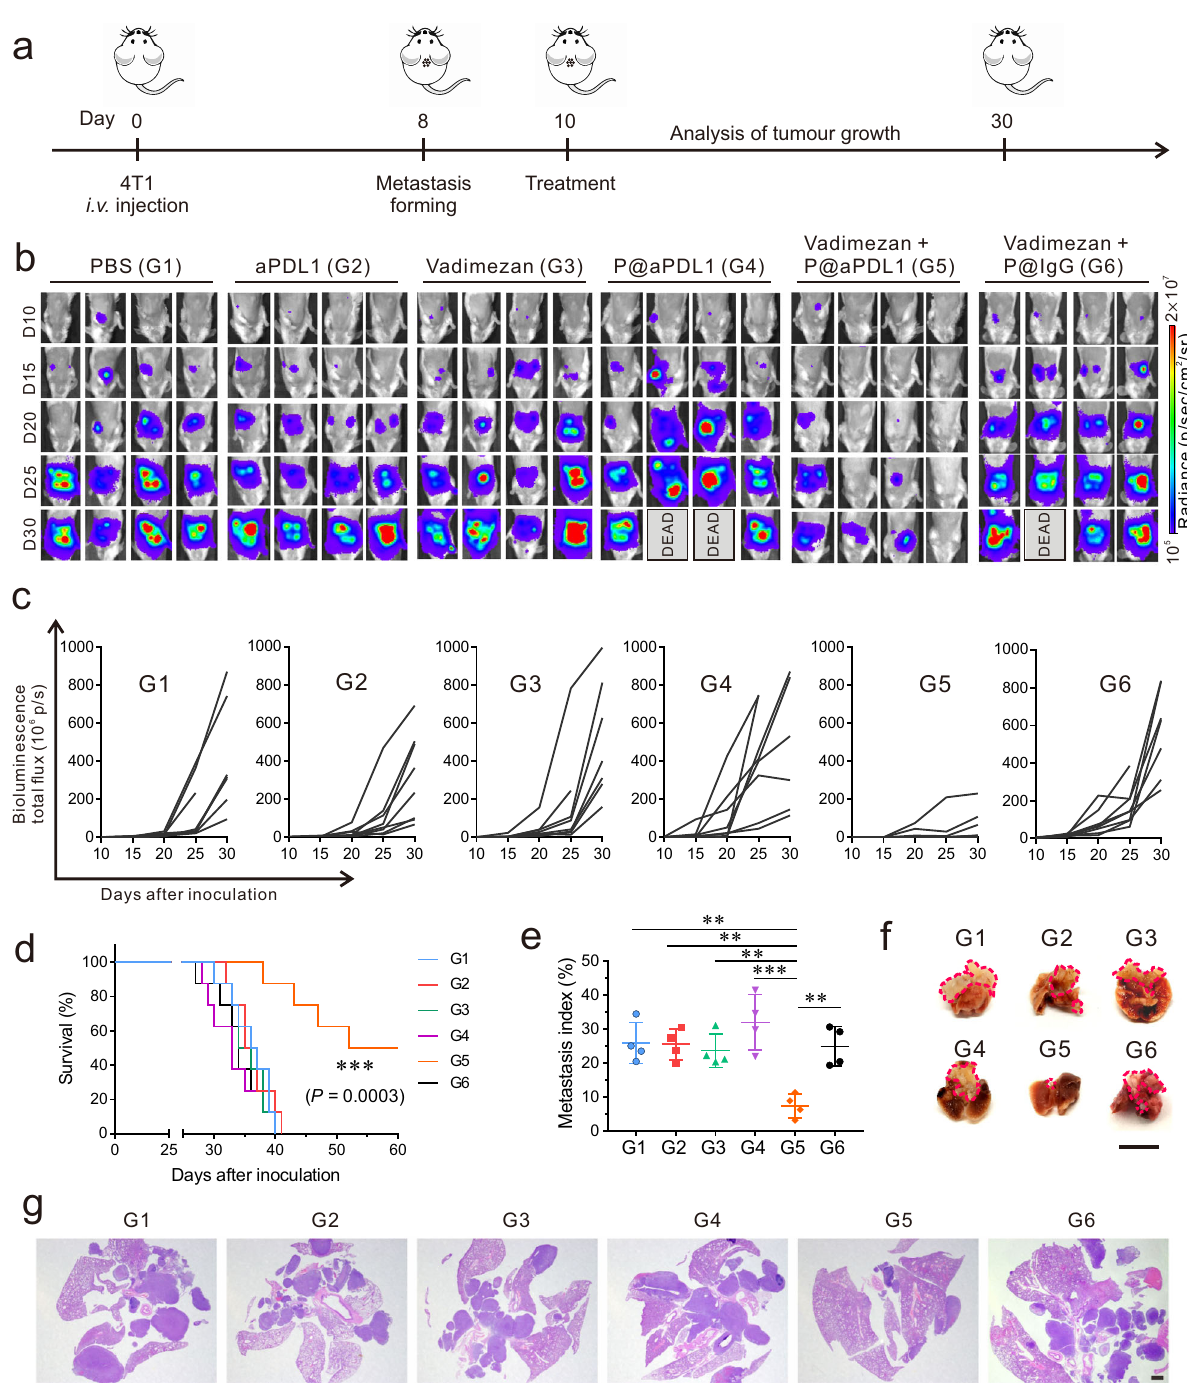
Fig. 3 P@aPDL1 combined with Vadimezan promotes anti-tumour effects in the 4T1 tumour model. a Schematics of the 4T1 breast cancer metastatic model and treatment. Mice received were treated 10 days post-tumour cells inoculation. Mice received 1 mg kg − 1 aPDL1 antibody or 15 mg kg −